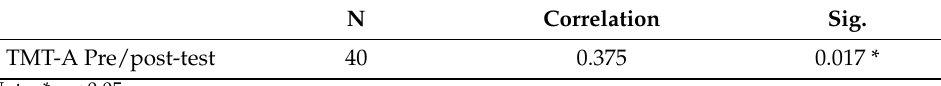
Table 14. Paired sample correlations of TMT-A.